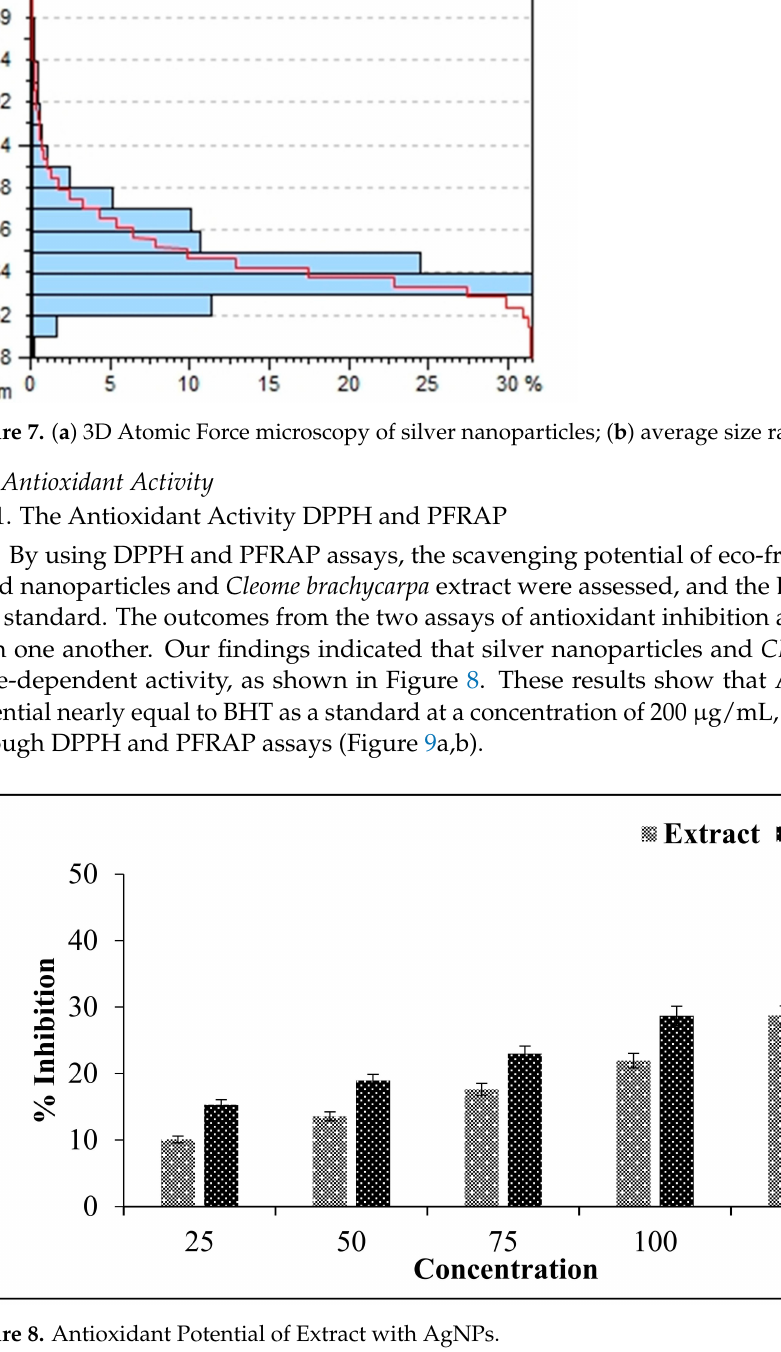
Figure 8. Antioxidant Potential of Extract with